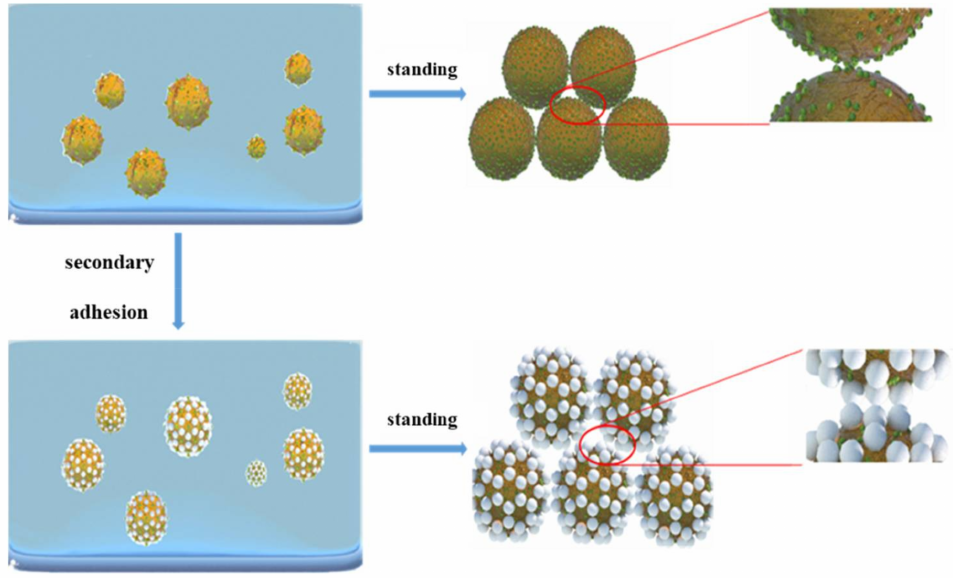
Figure 10. Changes in the packing shape of proppant particles after secondary